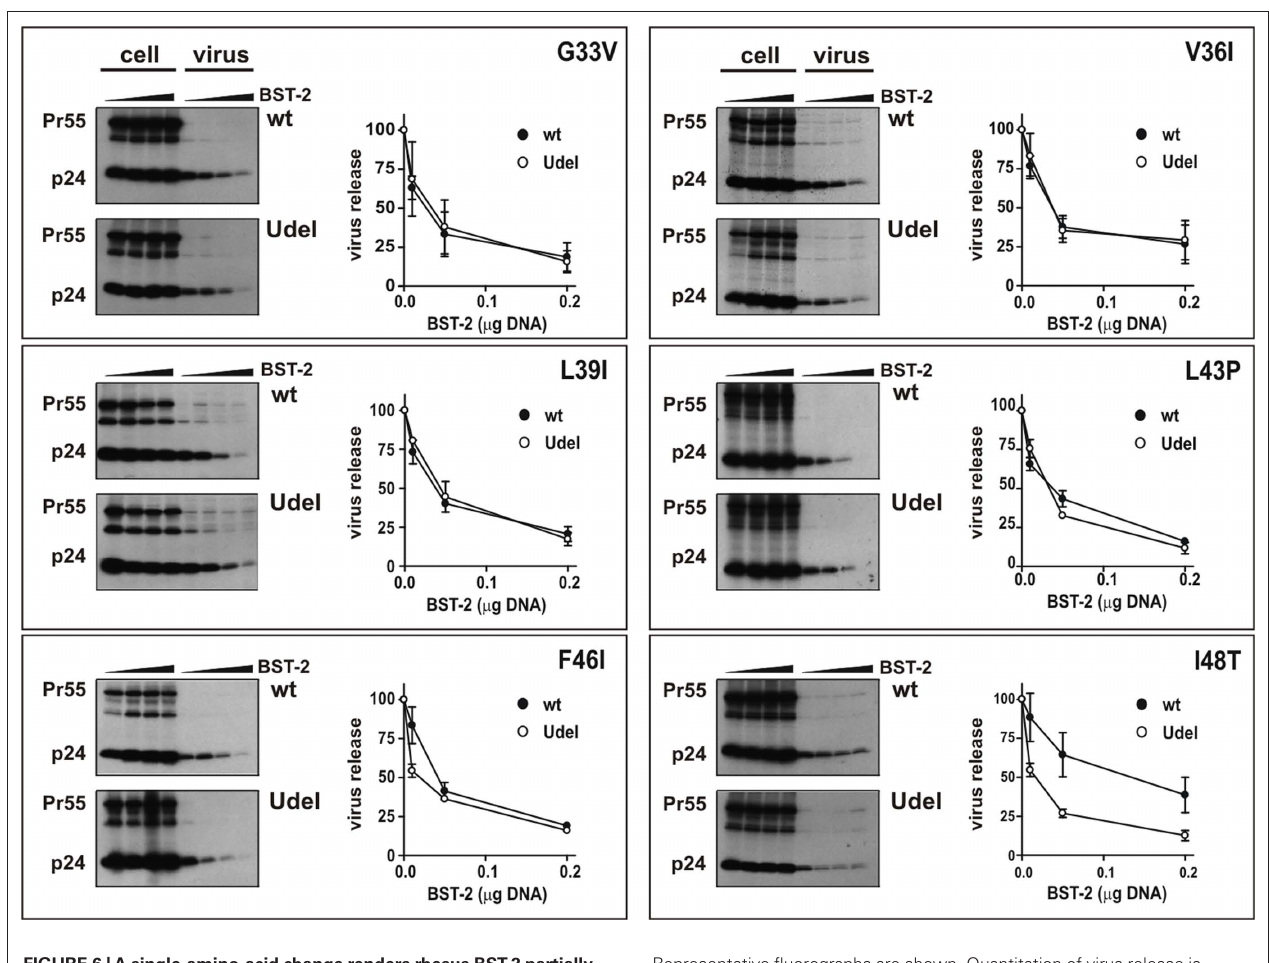
Representative fluorographs are shown. Quantitation of virus release is shown on the right of each panel and was performed as described in the legend to Figure 2B . Error bars reflect SEM from two independent